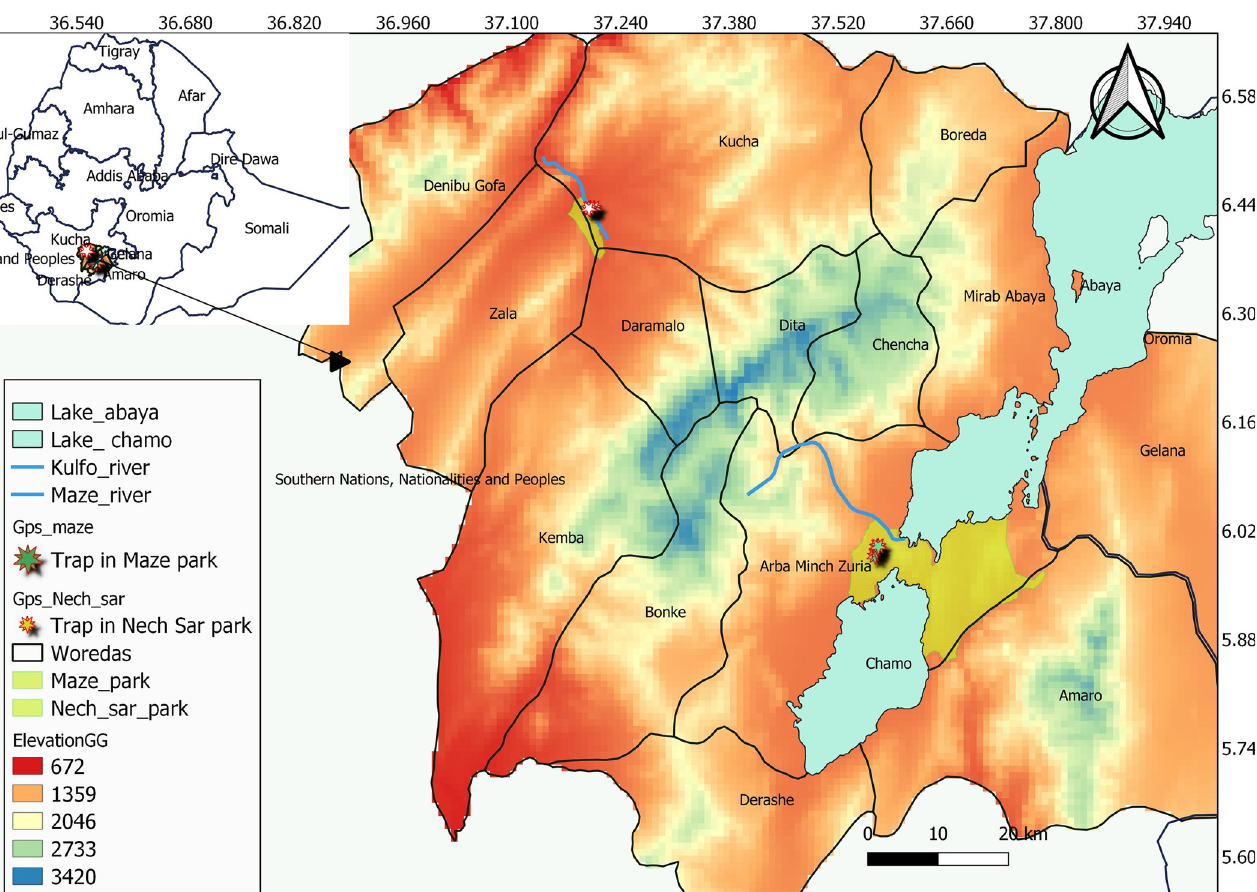
Fig 1. Map of the study area in Gamo zone, Southwest Ethiopia. Administrative boundaries, USGS Earth Explorer: (https://earthexplorer.usgs.gov), Roads, Water (River, lakes))–from DIVA-GIS (https://www.diva-gis.org/gdata), Central Stastical Agency and Regional of Finance and Economies Development).